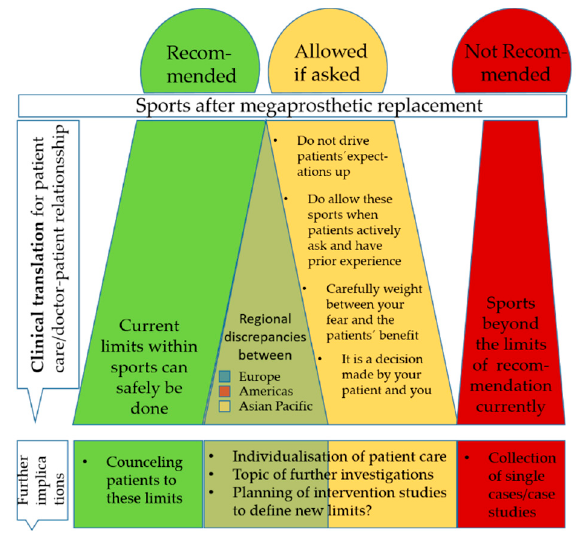
Figure 4. Graphical summary of sport recommendations after megaprosthetic replacement.